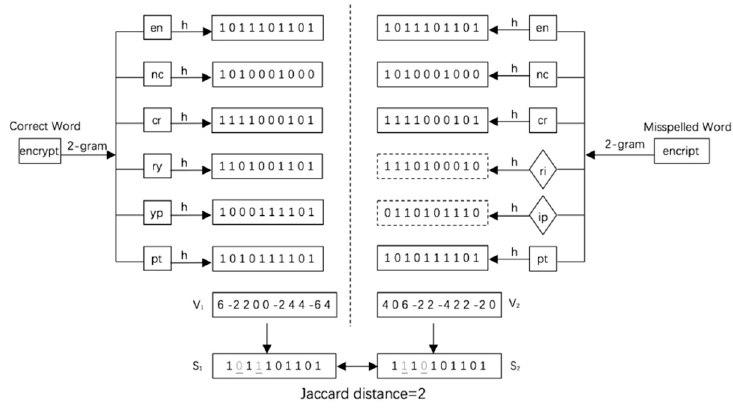
Figure 2. Key word fingerprint generation and comparison.